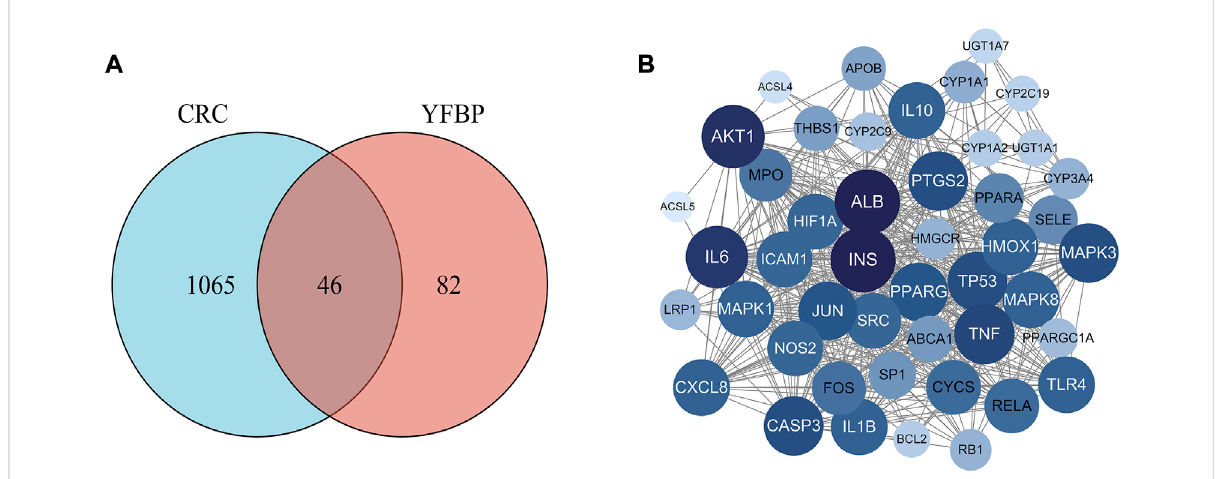
FIGURE 3 Potential target genes and the PPI network map of YFBP against CRC. (A) Venn diagram of potential target genes of YFBP against CRC. (B) PPI network map of 46 target genes.